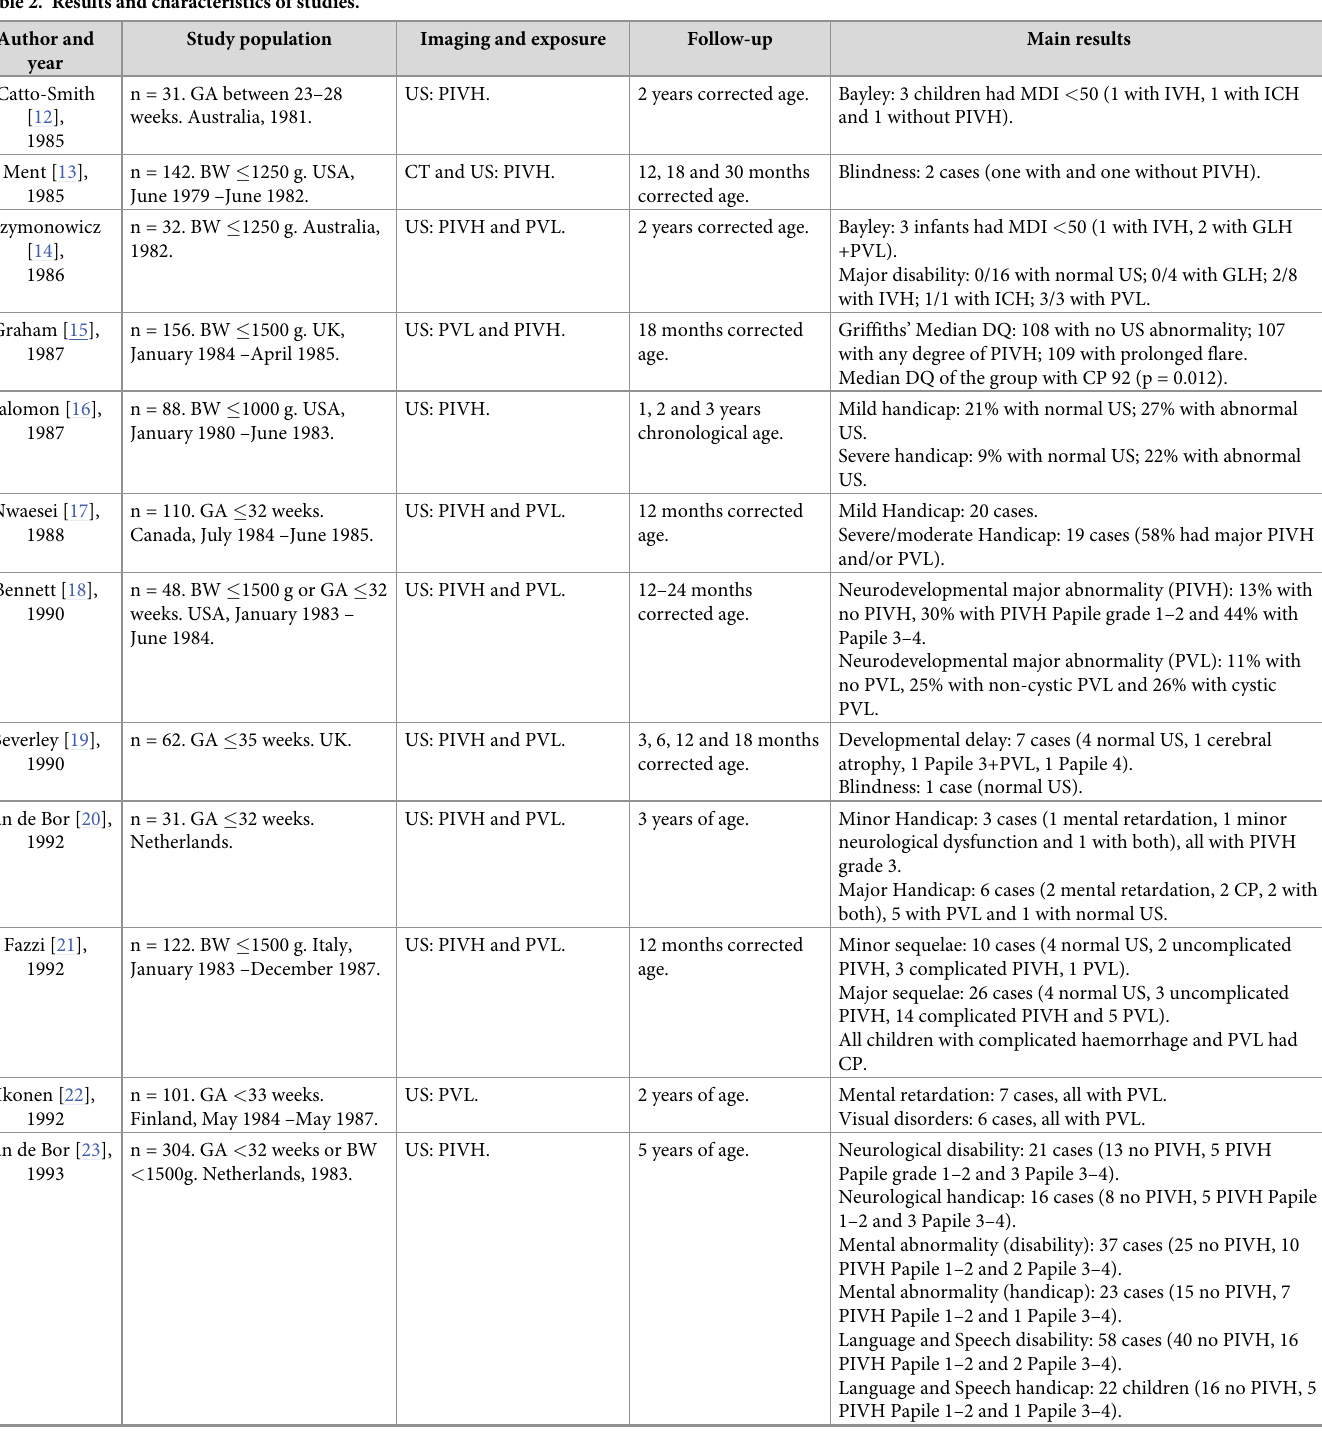
Table 2. Results and characteristics of